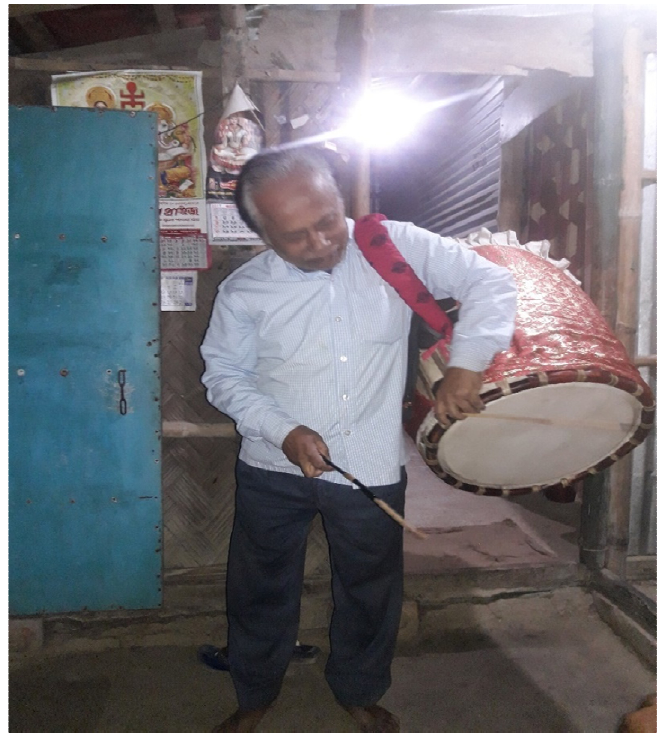
Figure 3. A dhaki at his home in North 24 Parganas demonstrating Durga Puja’s typical